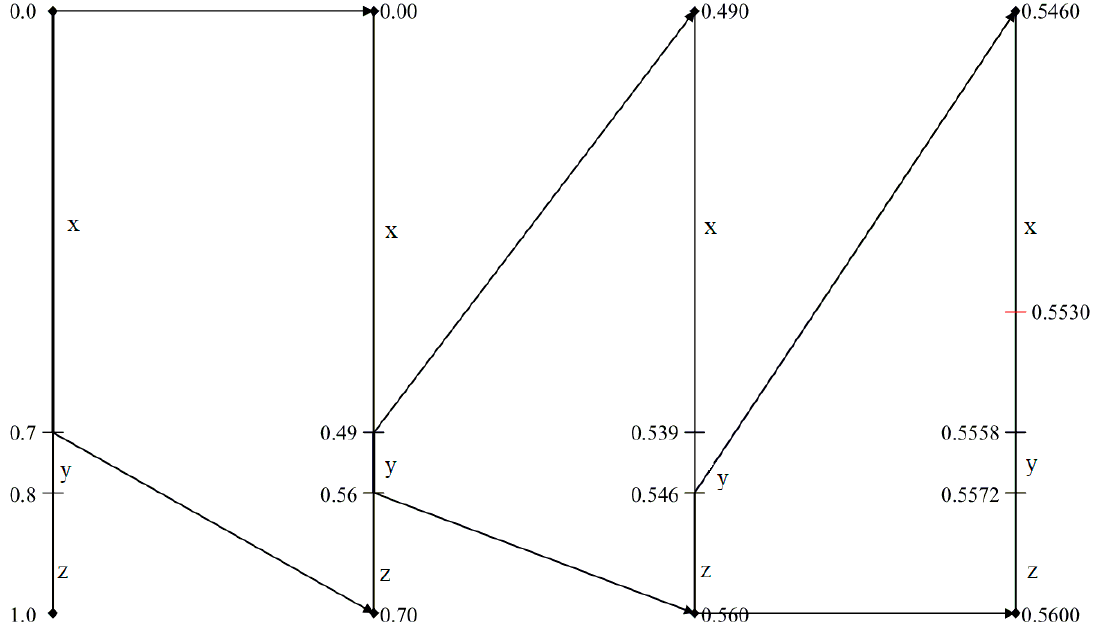
Figure 4. Determination of the alphabetic arithmetic coding label.